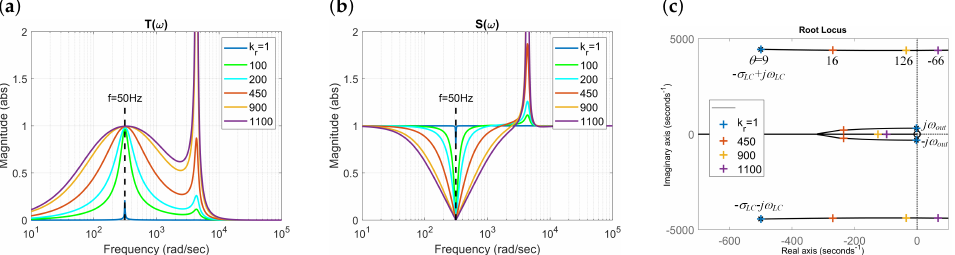
Figure 31. ( a ) T ( ω ) , ( b ) S ( ω ) and ( c ) root locus of R controlled system in the no-load mode for various k r . As k r increases, oscillability at f LC increases. The system loses stability at k r =